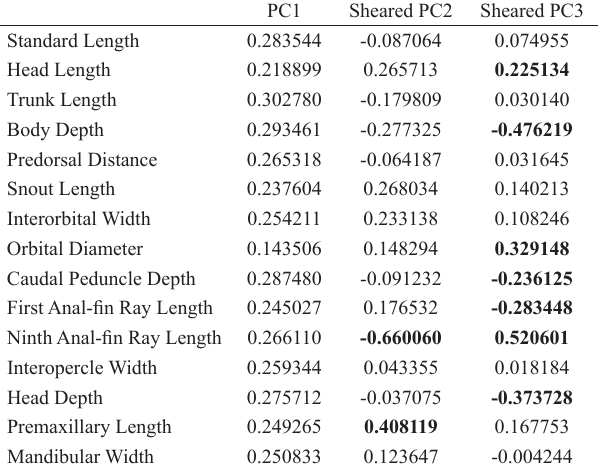
Tab. 1. Eigenvalues (prior to shearing) obtained from the PCA analysis on specimens of Schizodon fasciatus , S. borellii, S. dissimilis and S. intermedius .